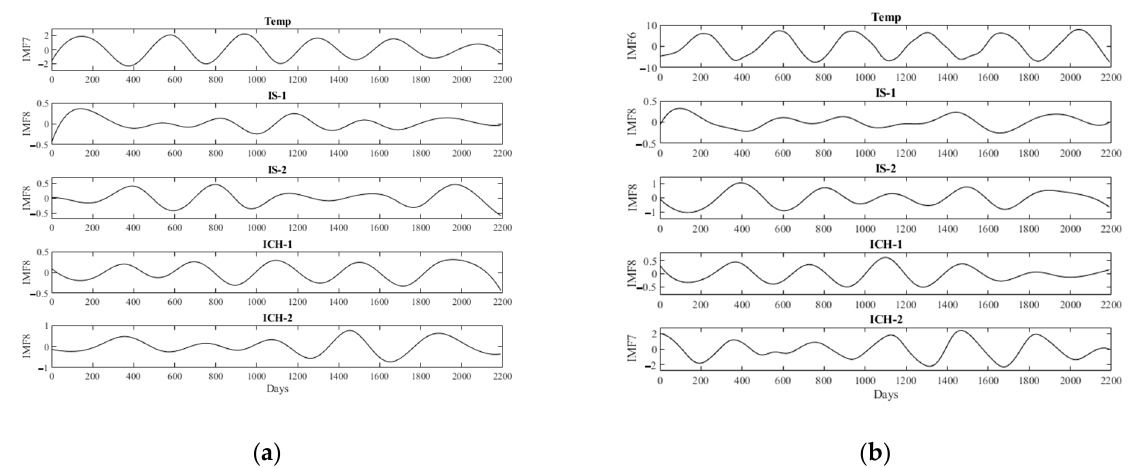
Figure 4. Six-period IMFs of the decomposed data in Kaohsiung City ( a ) and Taipei Area ( b ). Temp_Mean: daily mean temperature, IS-1: ischemic stroke in the middle-aged group, IS-2: ischemic stroke in the elderly group, ICH-1: intracerebral hemorrhage in the middle-aged group, ICH-2: intracerebral hemorrhage in the elderly group.